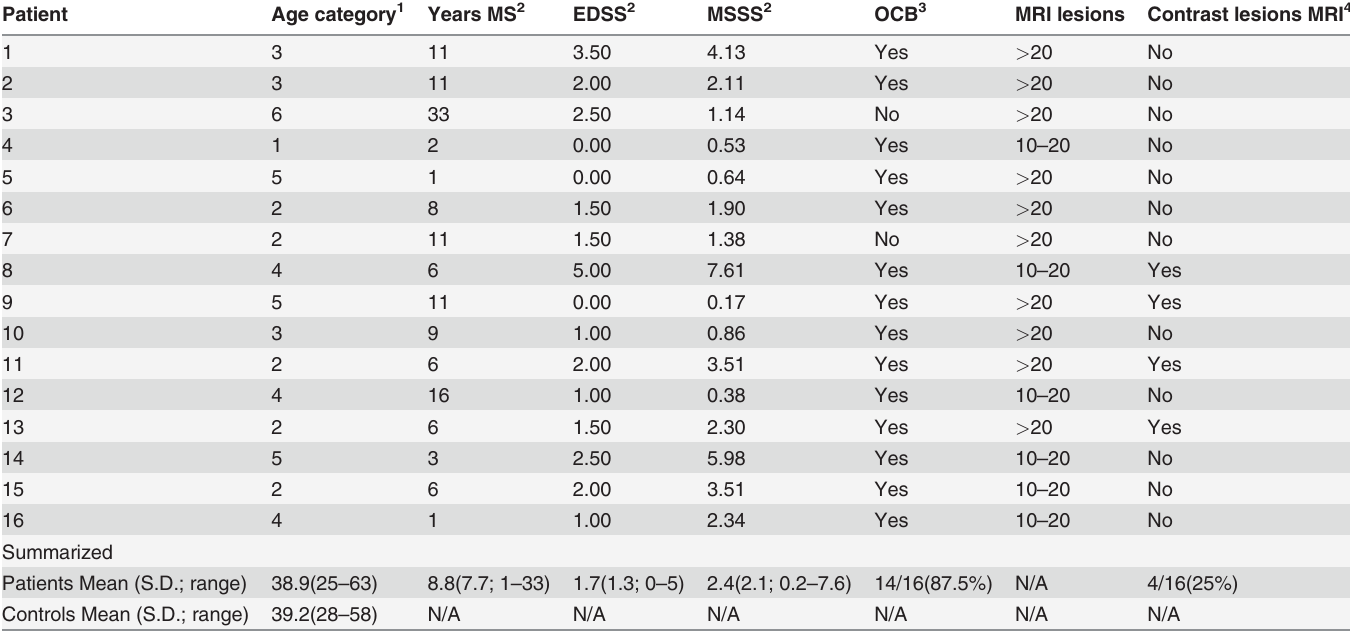
Table 1. Characteristics of individual MS patients and summaries of patients and